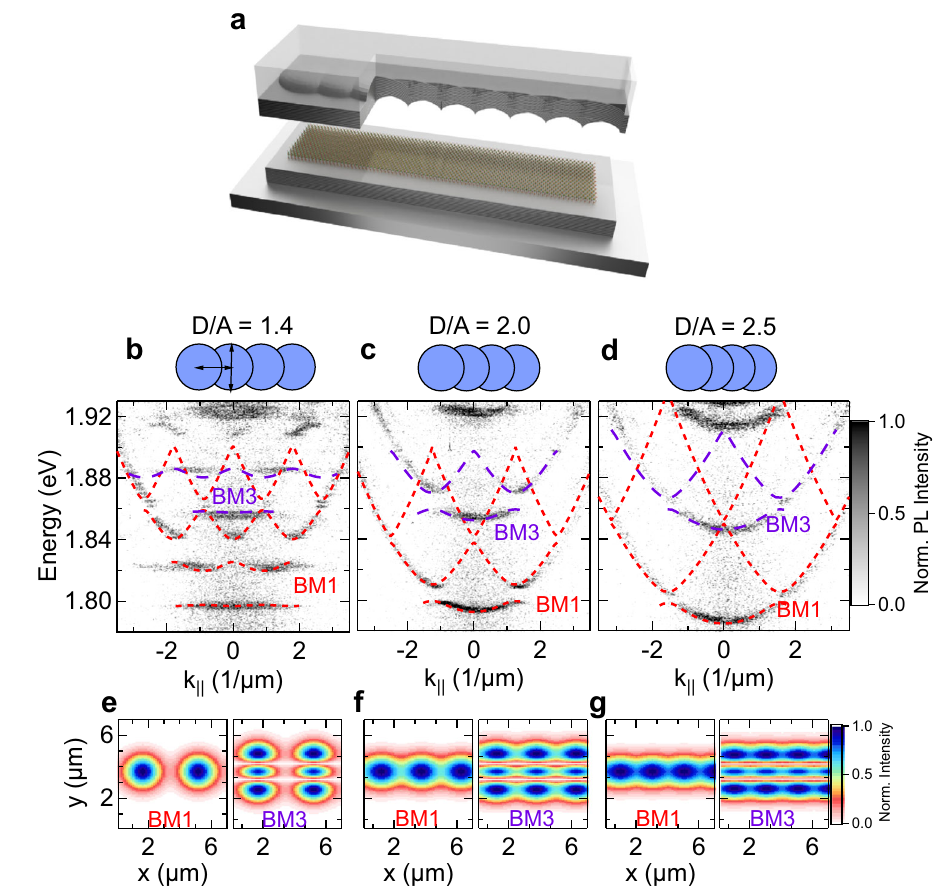
Fig. 2 Optical properties of TMDC polaritons in a lattice. a Sketch of the open cavity device with the 1D photonic lattice implemented in the top mirror. b – d Momentum-resolved photoluminescence spectrum from one-dimensional polariton lattices (see the sketch of the photonic potential in the top part of each panel) with increasing diameter (vertical arrow) to center-center distance (horizontal arrow) ratio D/A = 1.4, 2.0 and 2.5, respectively. The dispersion relation maps are encoded in a normalized, false-colour scale. The dashed lines are theory fi ttings to the experimental data. Experimental data are recorded with a pump power of ~100 µ W and an integration time of 480 s. e – g Pro fi les of the Bloch modes with one (BM1) or three fi eld maxima (BM3) in transverse to the lattice